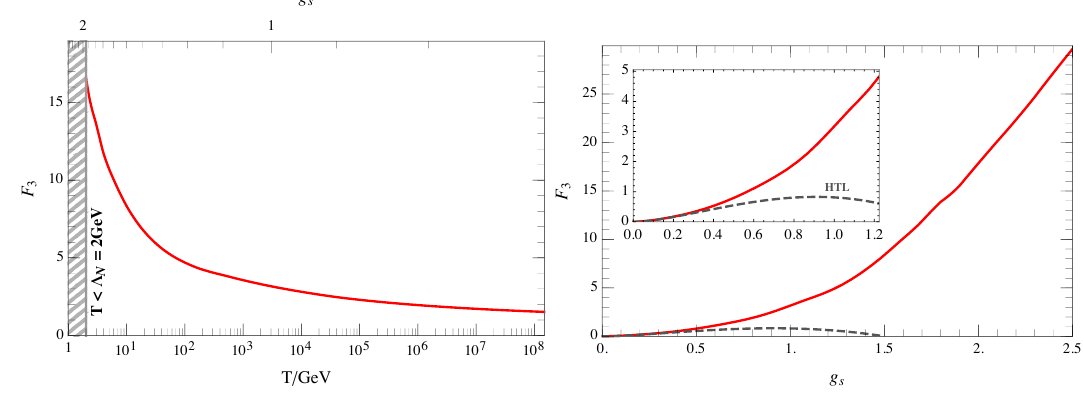
Figure 13 . The control function F 3 defined in eq. (2.8) as a function of the temperature (left) and the strong coupling g (right). The dashed gray line on the right panel corresponds to the Hard s Thermal Loop (HTL) approximation [37, 59], and it is valid only for small couplings g